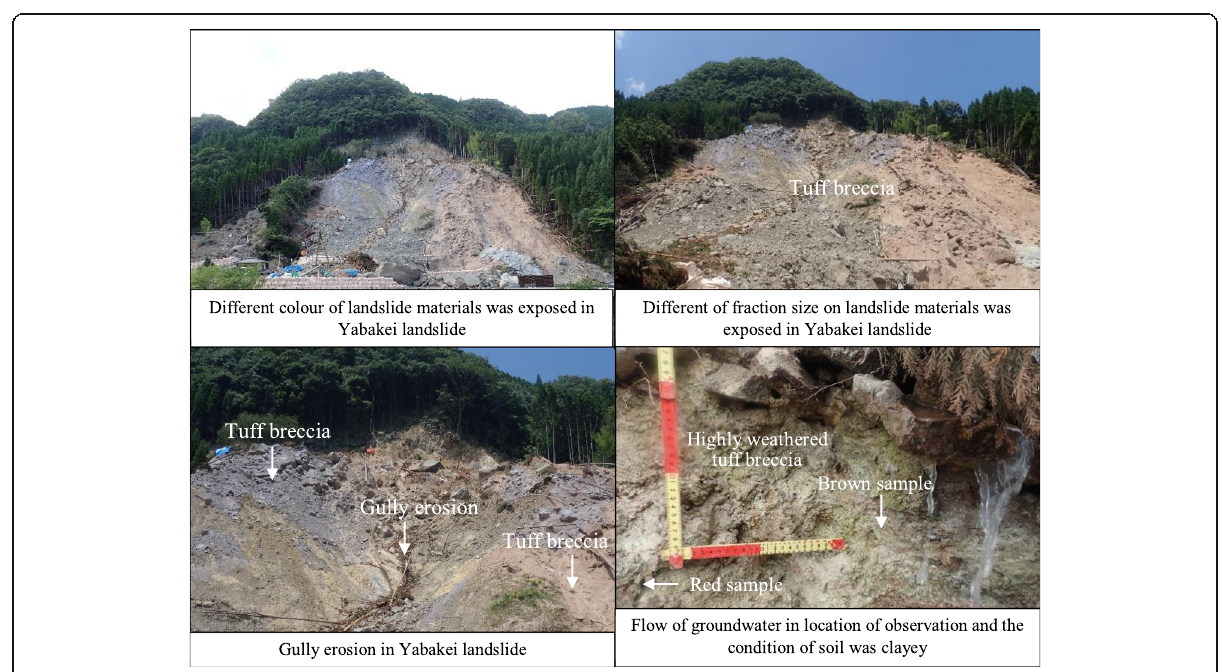
Fig. 7 Condition of Yabakei landslide (Photos taken on July 2018)